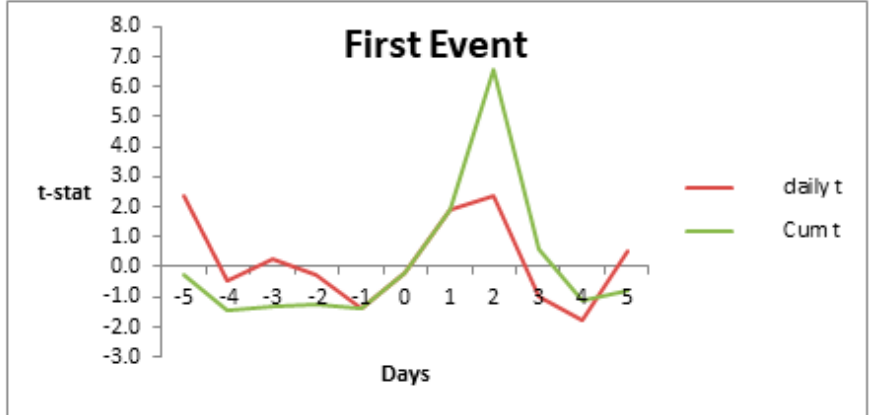
Figure 1. Daily t for AAR and cumulative t for CAAR. Source: Authors’ work.